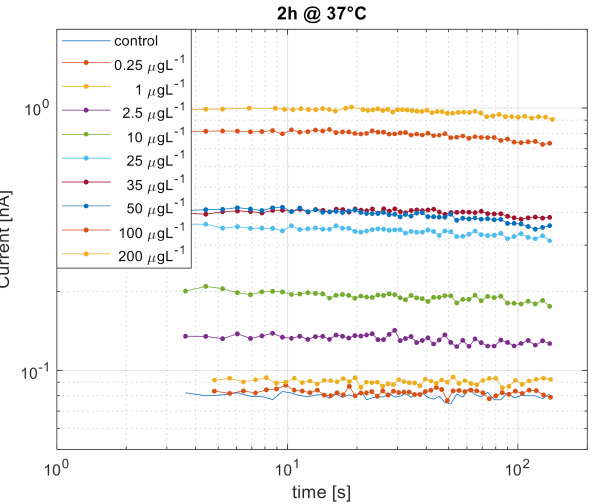
Figure 3. Mercury induced bioluminescence from the E. coli whole-cell biosensors detected by the SiPM instrument. Colors correspond to concentrations as explained in the legend inset. Samples were incubated with E. coli at 37 ◦ C for 2 h, after which the signal was acquired for about 100